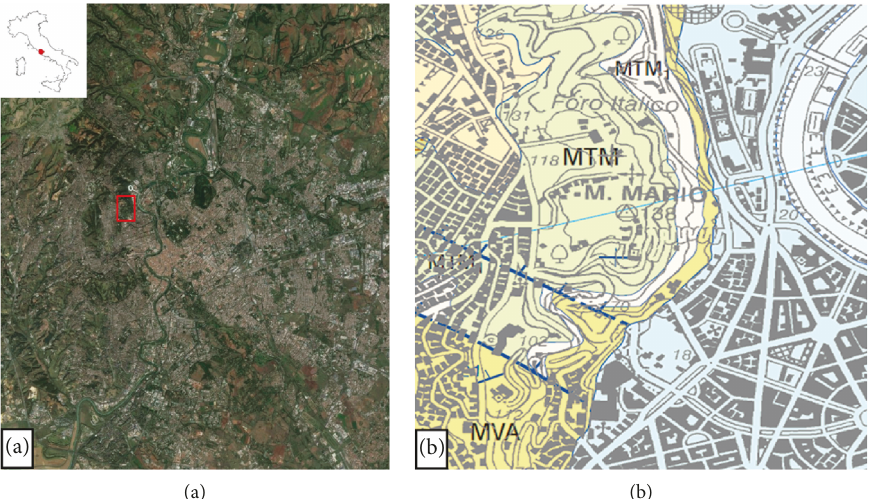
Figure 1: (a) Satellite image of the Rome urban area, with the location of Monte Mario Hill; (b) geological sketch of the Monte Mario area (from